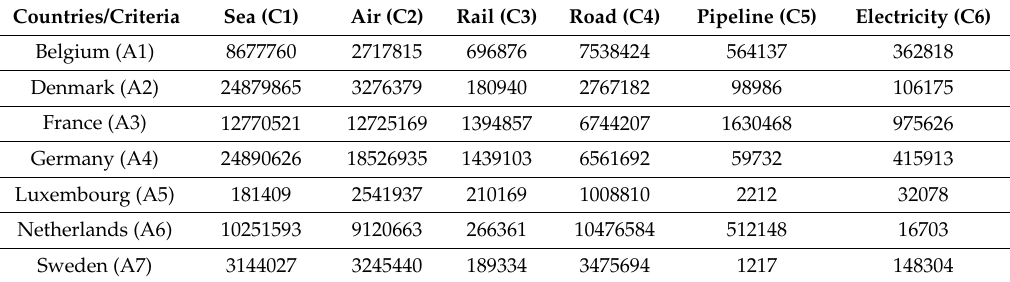
Table A1. Selected Data of Transport Export for the EU by 2016 (US Dollar,